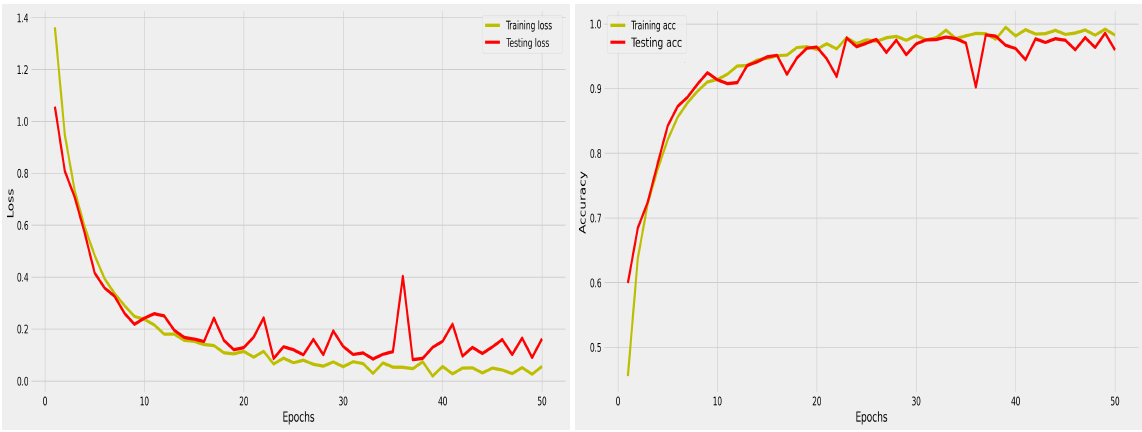
Figure 6. The loss and the accuracy training and validation curves for the ISIC2018 dataset.